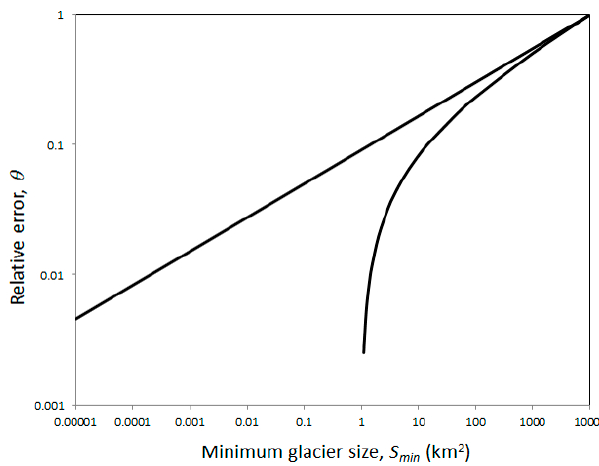
Fig. 5. The relative error in total volume calculated as a function of the minimum glacier size. The top curve shows the error when power-law scaling applies to N(S) at all glacier sizes. The bottom curve shows the error when power-law scaling does not apply to glaciers smaller than S deviate = 1 km 2 . Note that the difference in relative error is small (a fraction of an order of magnitude) for sizes larger than roughly 10 km 2 and is less than an order of magnitude for almost all sizes larger than S deviate = 1 km 2 . Calculations for this plot use γ = 1 . 36, β = 2 . 1, and S max = 10 000 km 2